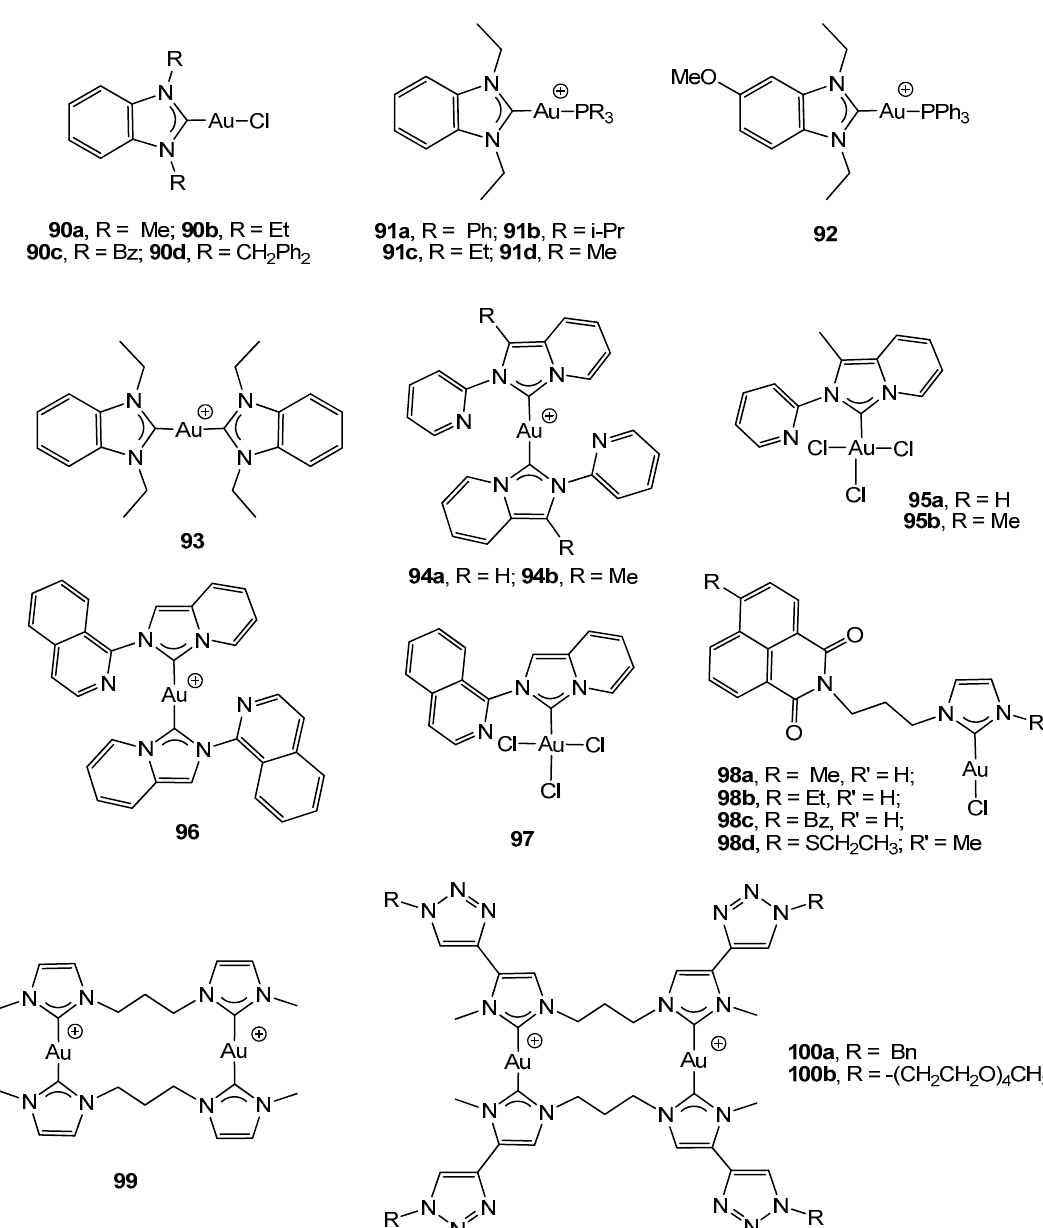
Figure 7. Structures of Au-NHC complexes.